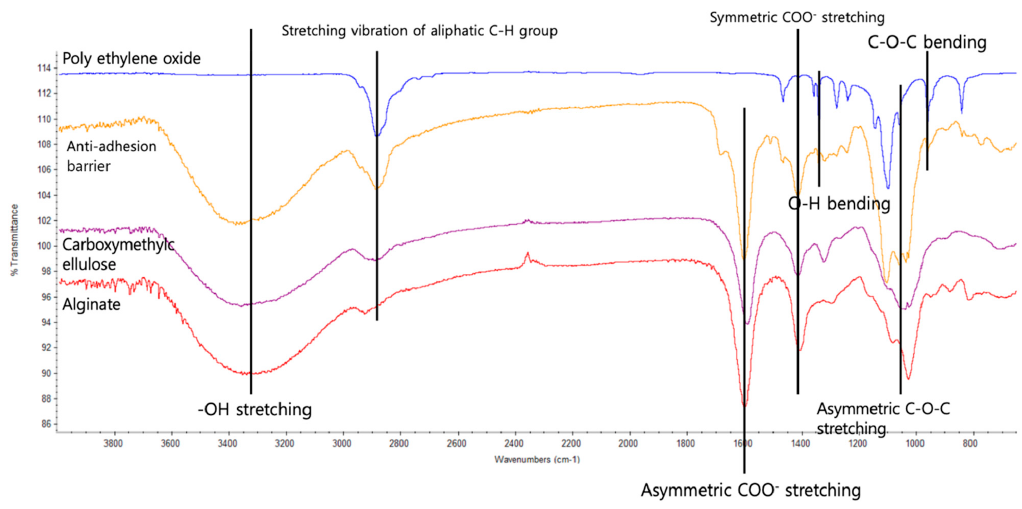
Figure 4. FT-IR analysis data on the alginate/CMC/PEO film (anti-adhesion barrier).